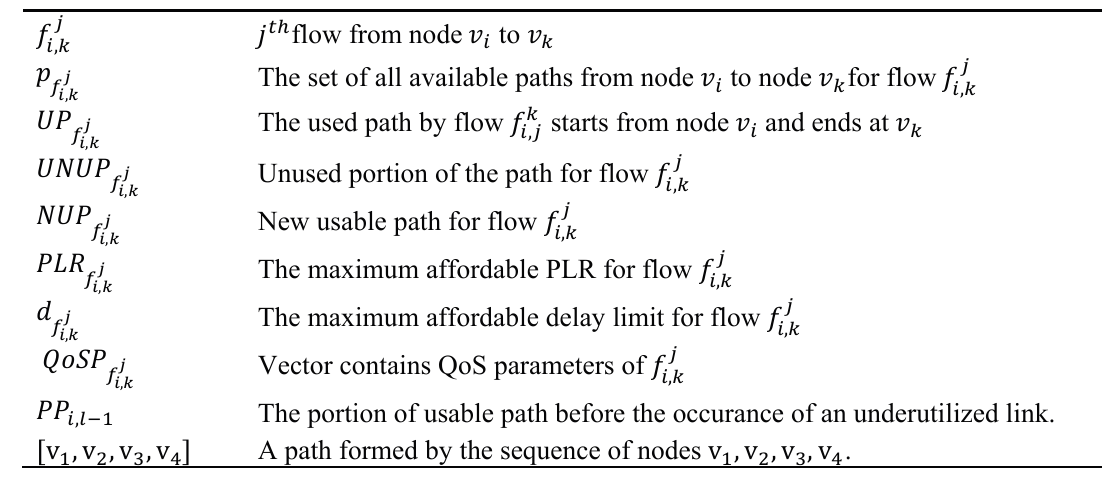
Table 2. Notations for LNR-RCTD algorithm.